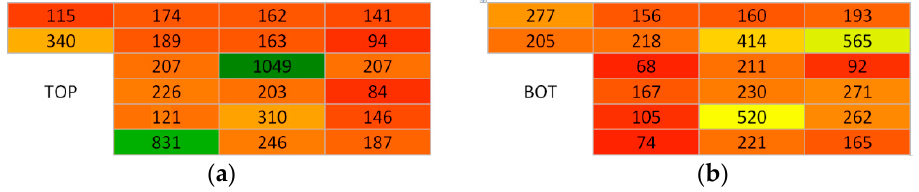
Figure 19. TOP/Upper- ( a ) and BOT/lower-layer ( b ) cell capacities determined with 1 A cells charging method.